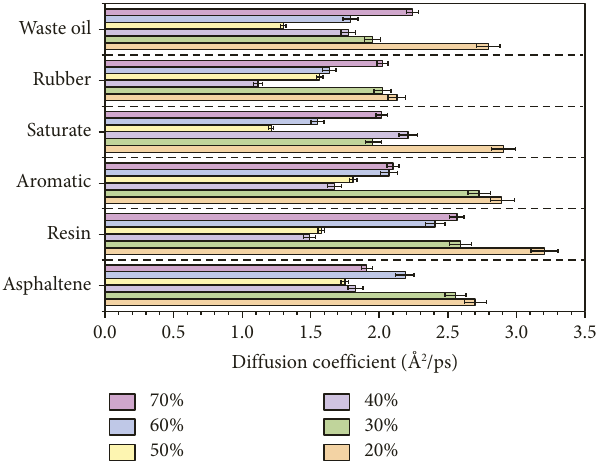
Figure 8: Diffusion coefficients of components in